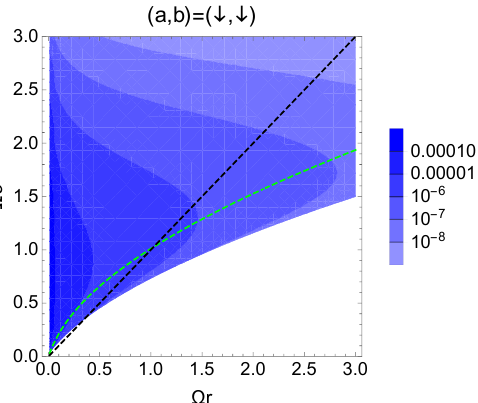
Figure 4. The contour plot of the negativity with the initial condition |↓ A ↓ B (cid:105) . The green dashed line denotes β = 1, and the above this line β > 1.